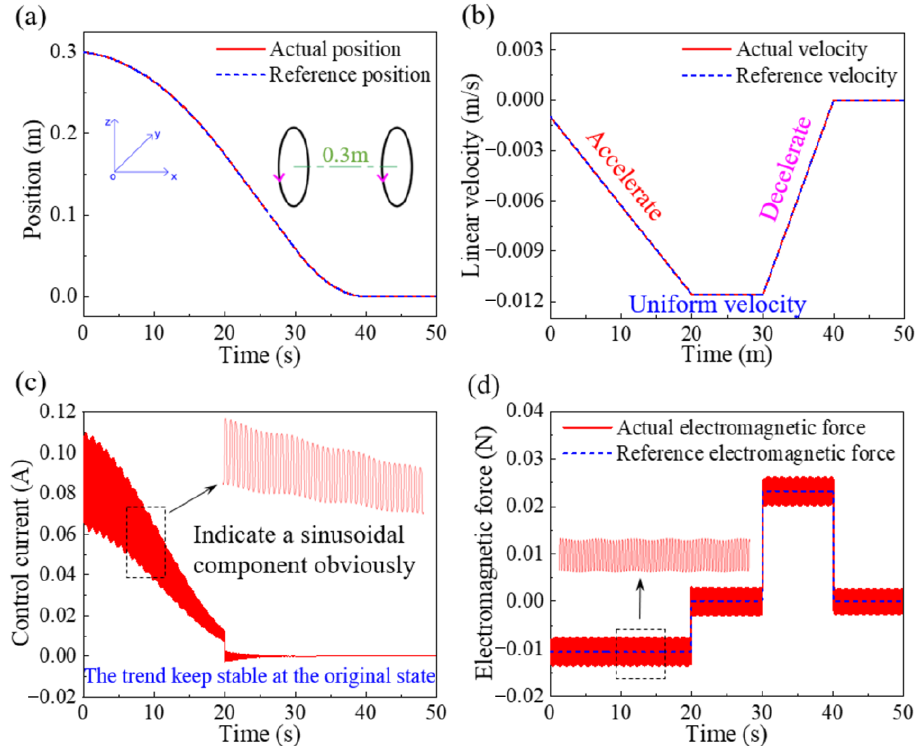
Figure 10. The position ( a ), linear velocity ( b ), control current ( c ), and electromagnetic force ( d ) of the sliding mode control based on exponential reaching law with sinusoidal interference. sliding mode control based on exponential reaching law with sinusoidal